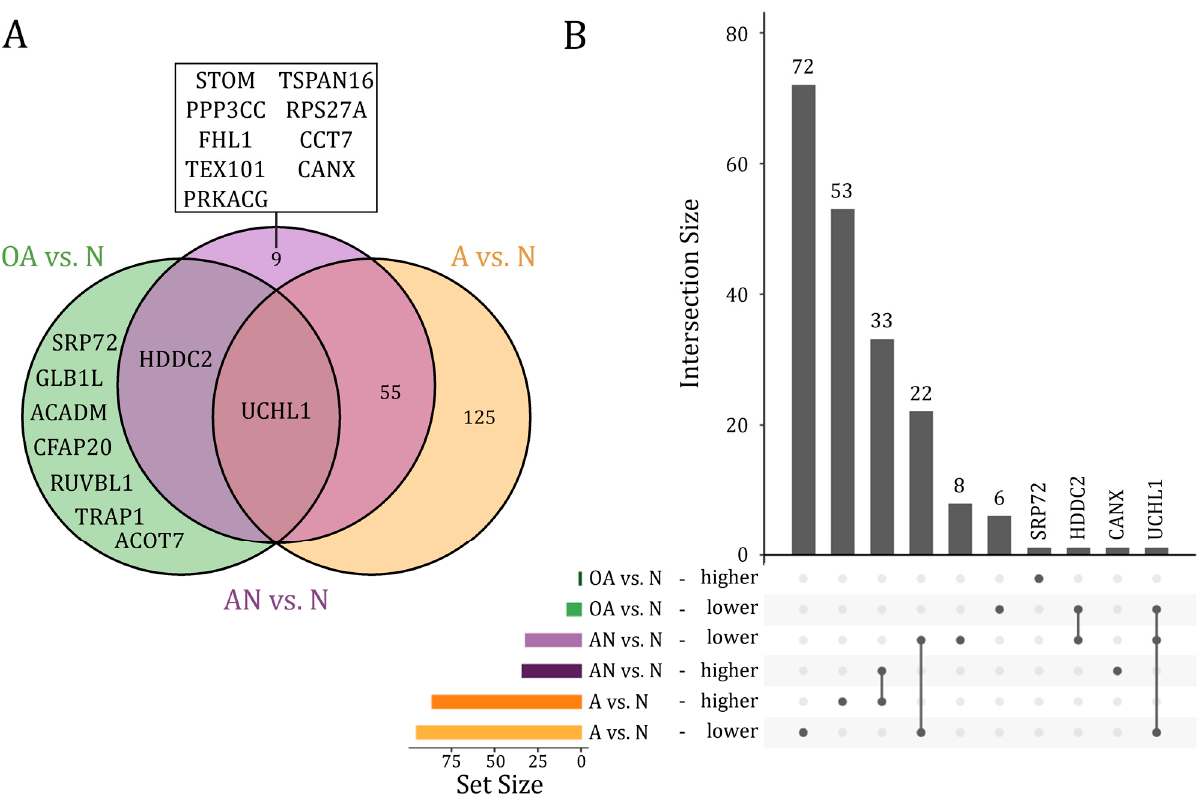
Figure 2. ( A ) Venn diagram and ( B ) Upset plot of proteins that showed signi fi cantly di ff erent abundance levels (adjusted p -value < 0.05) in the comparison of subfertile men compared to the normozoospermic controls (AN vs. N), the oligoasthenozoospermic men compared to the normozoospermic controls (OA vs. N), and the asthenozoospermic men compared to the normozoospermic controls (A vs. N).